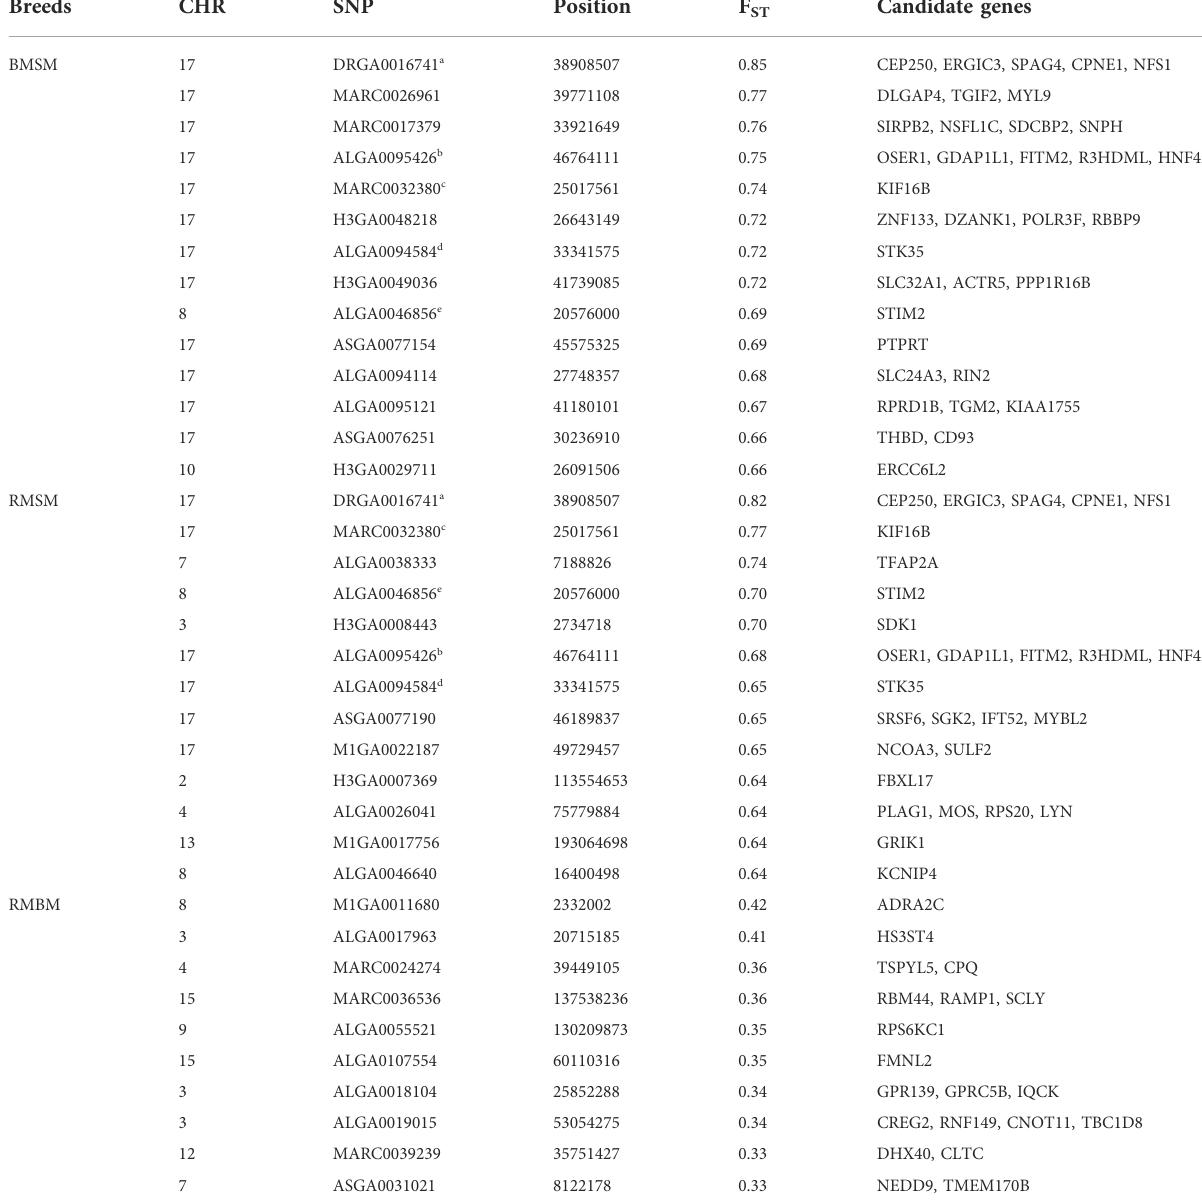
TABLE 1 Summary information of signi fi cant SNPs and candidate genes from F st comparison of three Mangalitsa pig breeds (BM, SM and RM). Superscripts a-e denote common SNPs across pairwise comparisons. Breeds CHR SNP Position F ST Candidate genes BMSM